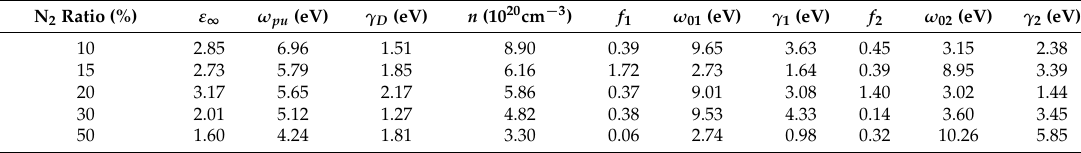
Table 2. Results based on Drude–Lorentz fits of the dielectric function nitride